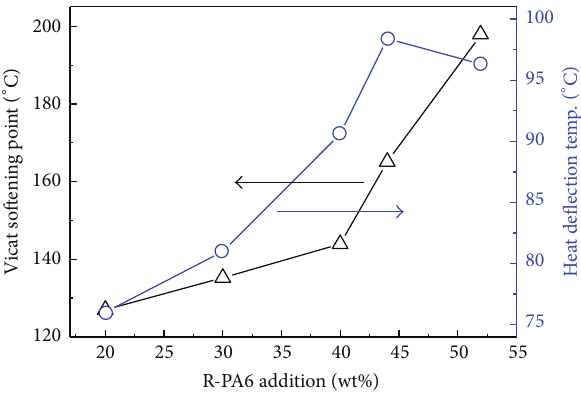
Figure 1: The effect of R-PA6 content on the thermal performance of